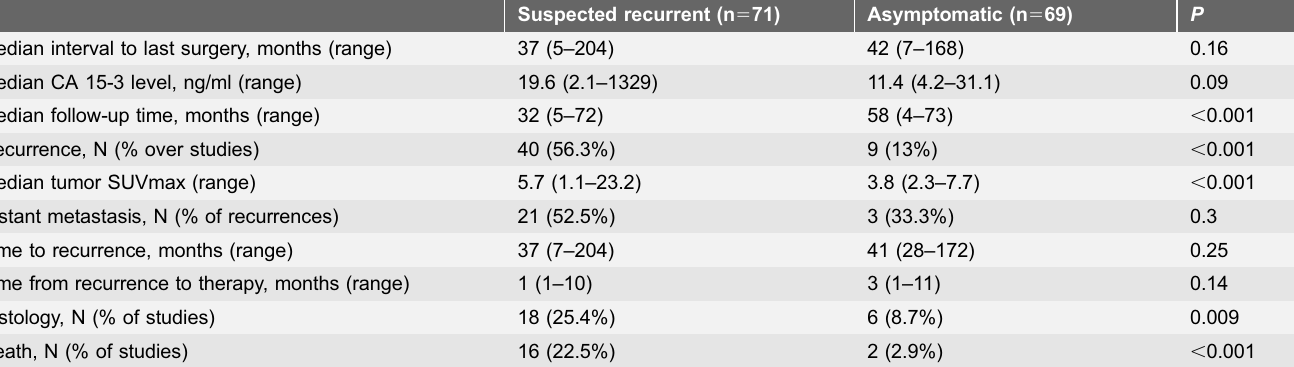
asymptomatic patients. The median tumor SUVmax in patients with suspected recurrence and asymptomatic patients was 5.7 (ranged 1.1 to 23.2) and 3.8 (ranged 2.3 to 7.7), respectively ( P , 0.001). Two chest wall lesions less than 1 cm (0.7 cm and 0.8 cm, respectively) with SUVmax of 1.4 and 2.3 and another two abnormalities on a CT (internal mammary chain and pleura) with SUVmax of both 2.3 were interpreted as being positive for recurrent disease. Of the latter group, 4 cases were proven with histological analysis, including 2 cases of second primary breast cancers with different histopathologic subtypes and 2 cases of fat necrosis over prior operation sites. The remaining cases were confirmed as benign in follow-up studies and included 2 cases of pulmonary tuberculosis, 1 reactive node case and 2 cases with unknown causes of increased FDG uptake in the liver and bone. Seven false-negative diagnoses were noted, 4 of which identified malignancies (based on histology) of liver metastasis, recurrent breast lesion, liver metastasis and malignant pleural effusion at 1, 3, 9 and 11 months, respectively, after the PET/CT scan. The recurrent breast lesion, a 0.5 cm nodule with a SUVmax of 1.1, was interpreted as being a benign lesion. An excisional biopsy of the nodule was performed, and the pathological analysis revealed metastasis. The other 3 cases recurred within 12 months, with disease progression (n 5 2) and response to therapy (n 5 1) during follow-up. In the remaining patients, no recurrent disease was detected during the follow-up period of at least 12 months, which included close surveillance, the periodic evaluation of serum CA 15-3 levels and other imaging modalities.